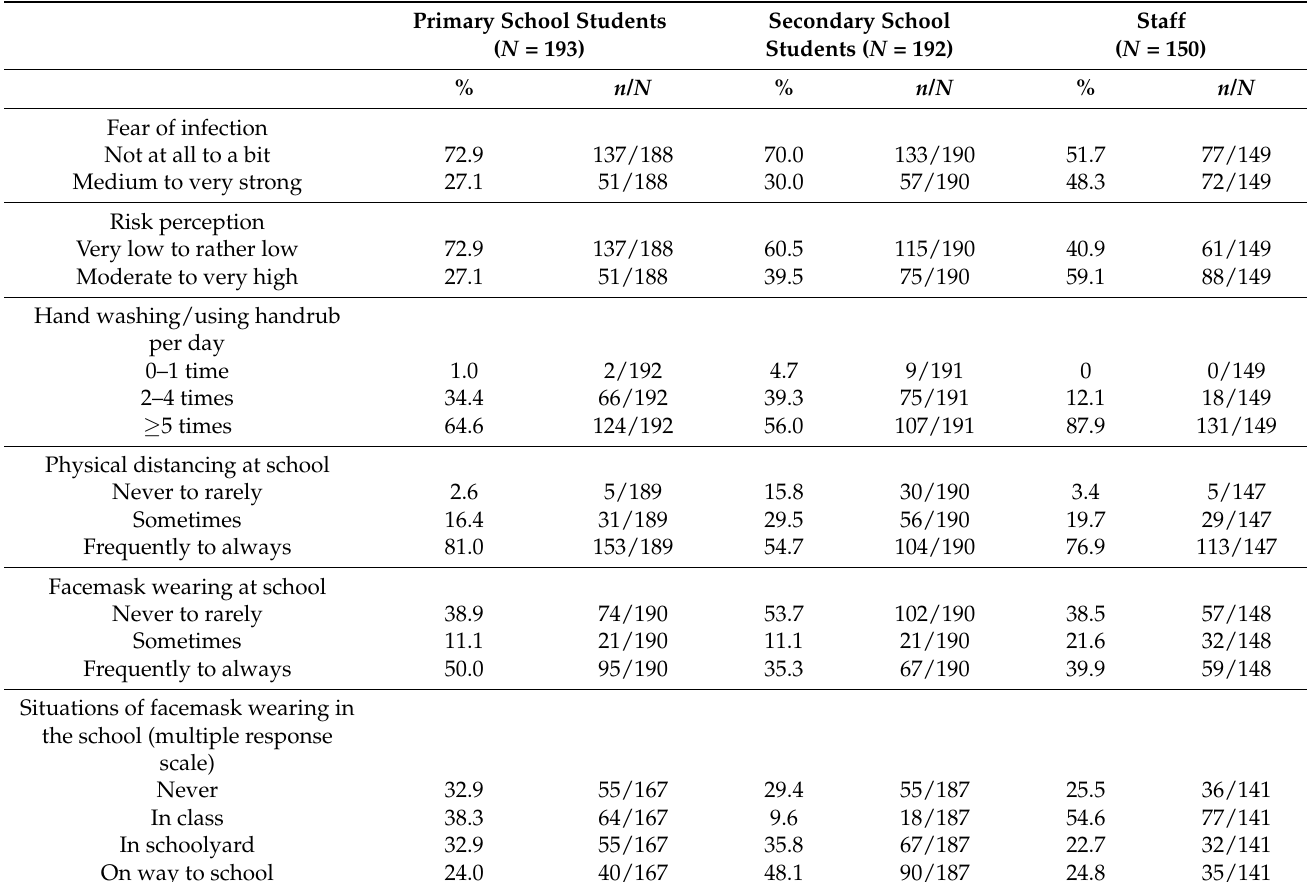
Table 2. Proportions for reported fear of infection, risk perception, and health